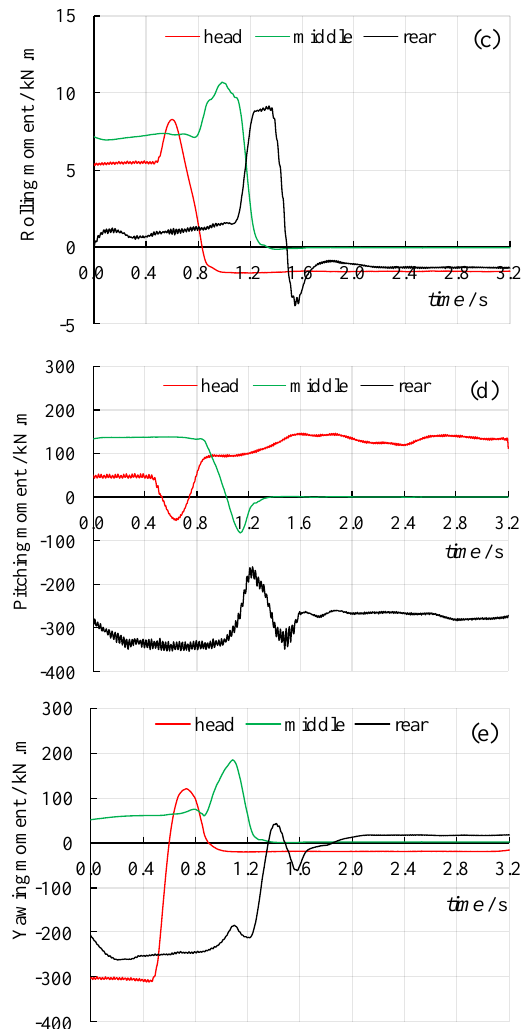
Figure 16. Evolution of five aerodynamic loads with respect to time during the train entering the tunnel (train speed = 250 km/h, crosswind velocity = 25 m/s): (a)side force; (b)lift force; (c) rolling moment; (d) pitching moment; (e) yawing moment.